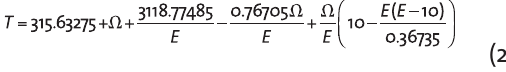
Comparison between the experimental and predicted forces versus angular veloci- ty, W , at eccentricity